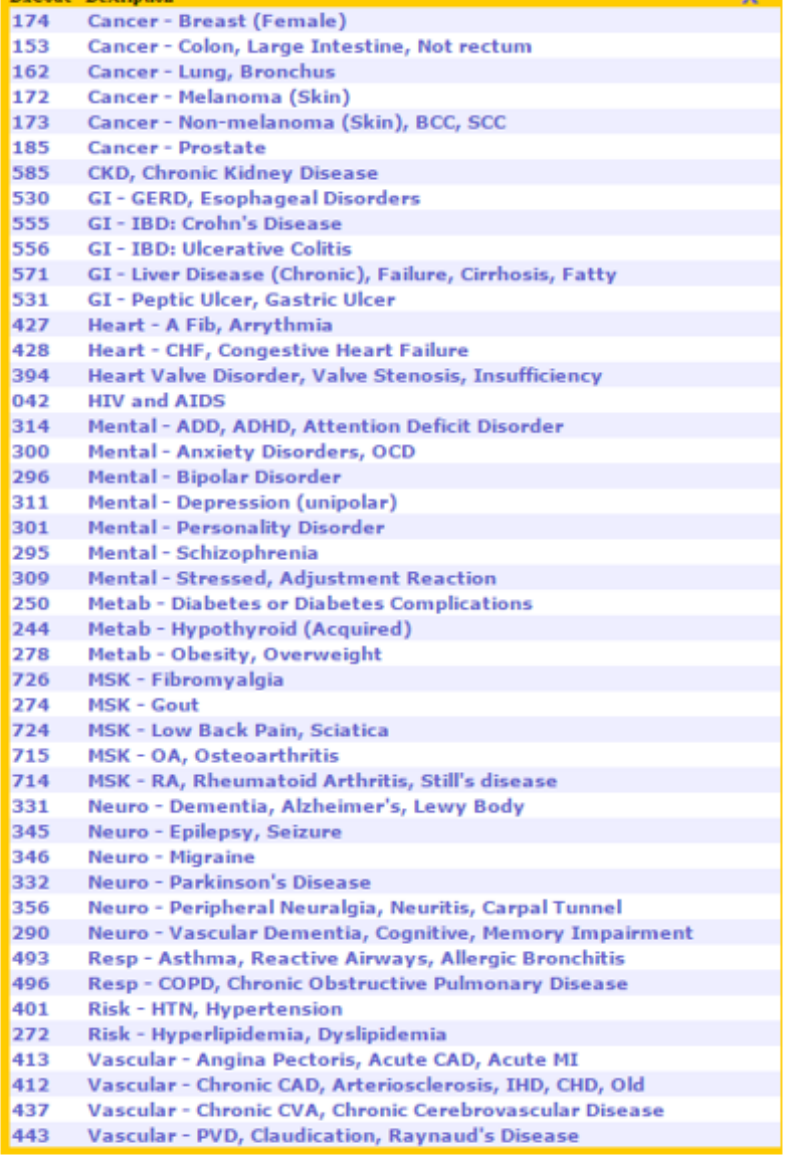
Figure 2. Screenshot of the billing diagnostic quick-pick